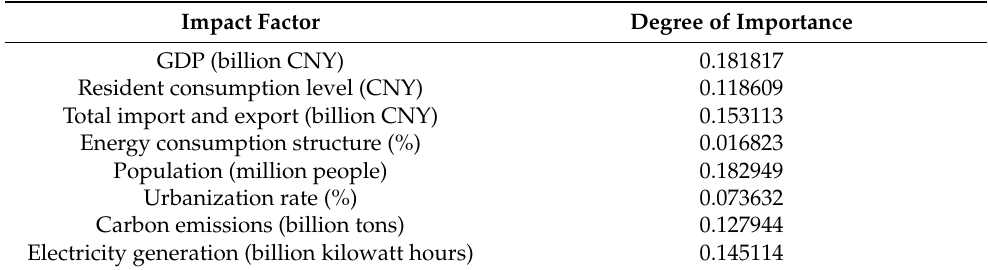
Table 1. Table of random forest